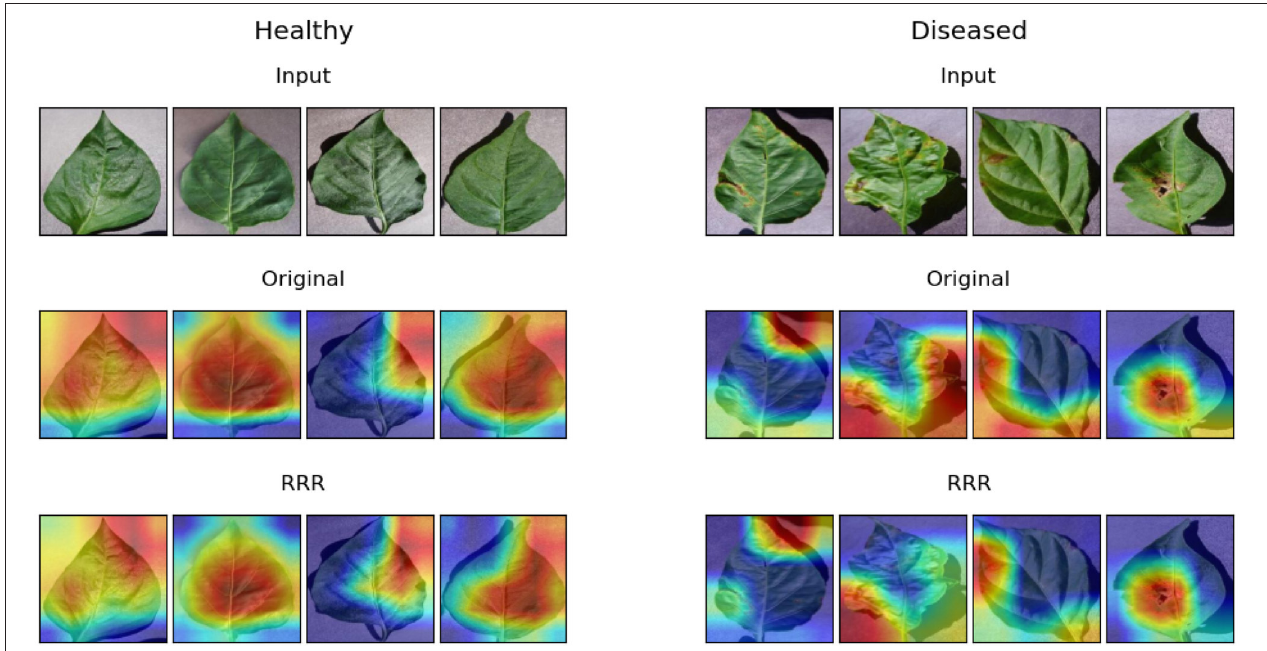
FIGURE 8 | Examples of model explanations for the second task. The two columns reflect the explanations of healthy leaves and diseased leaves. For each column, the three rows display the input image, original explanation, and the explanation with the consideration of expertise. A warmer color in the explanation indicates a higher contribution value, denoting a more important pixel for the classification task.